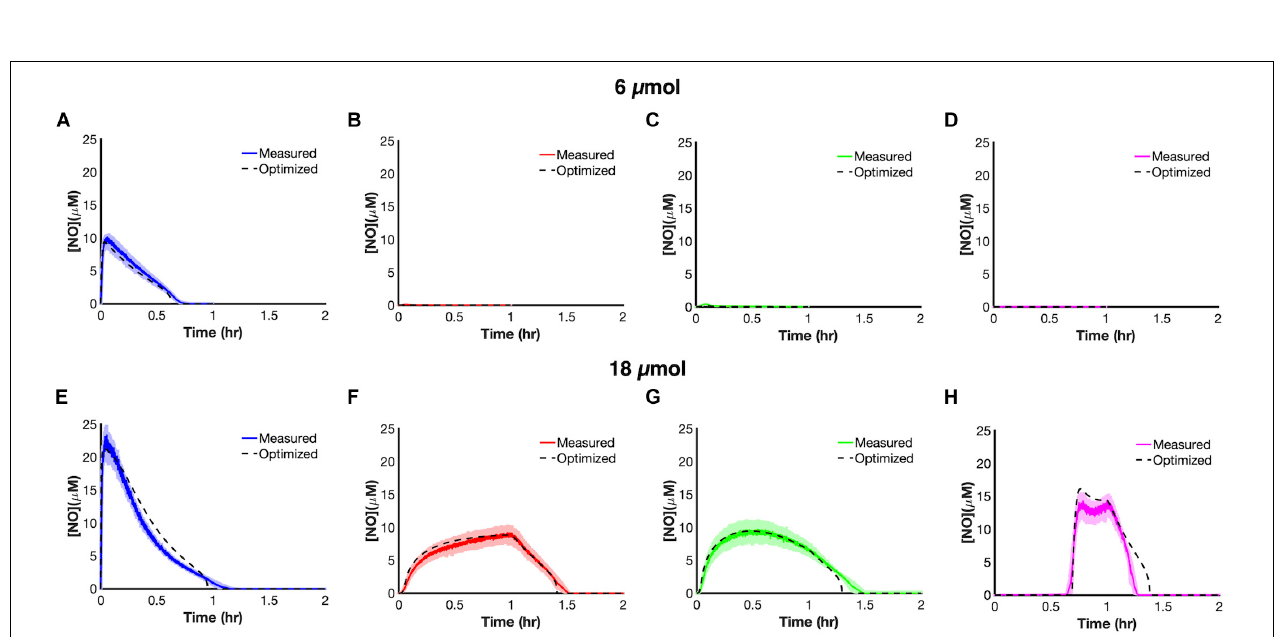
FIGURE 3 | Model training and optimization on NO dynamics observed at 6 µ mol (A–D) and 18 µ mol (E–H) for the four principle dosing modes (refer to Supplementary Table S6 for a list of optimized parameters). Cultures of E. coli were grown to exponential phase and inoculated in a bioreactor at an OD 600 of 0.05. Five minutes after inoculation, PAPA NONOate was delivered over an hour in one of four ways (bolus- blue; constant-red; ramp down-green; ramp up-pink). Solid lines represent the mean of three independent experiments, whereas the lightly shaded areas represent the standard error of the mean. Dashed black lines represent simulation results using the ensemble of parameter sets (ER < 10, 28 sets in total) trained on the data presented in this figure. Simulations from the ensemble members greatly overlapped, thus resembling a single line.